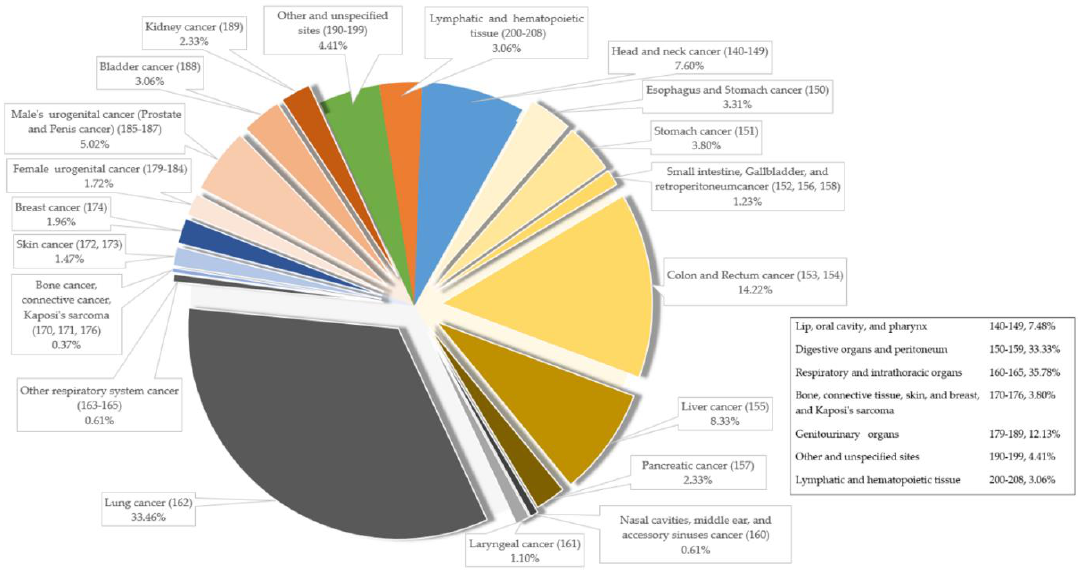
Figure 2. The distribution of cancer types among COPD patients who received PC.